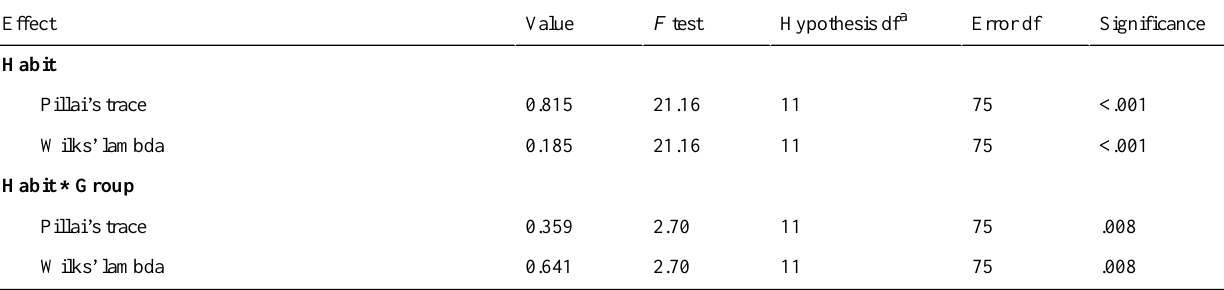
Table 3. Multivariate test results.